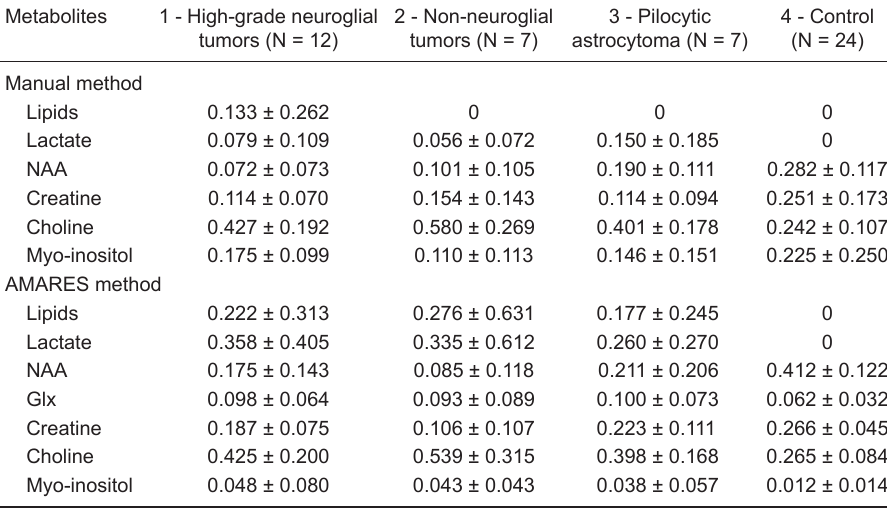
Table 3. Mean quantification results obtained with the manual and semi-automatic methods.